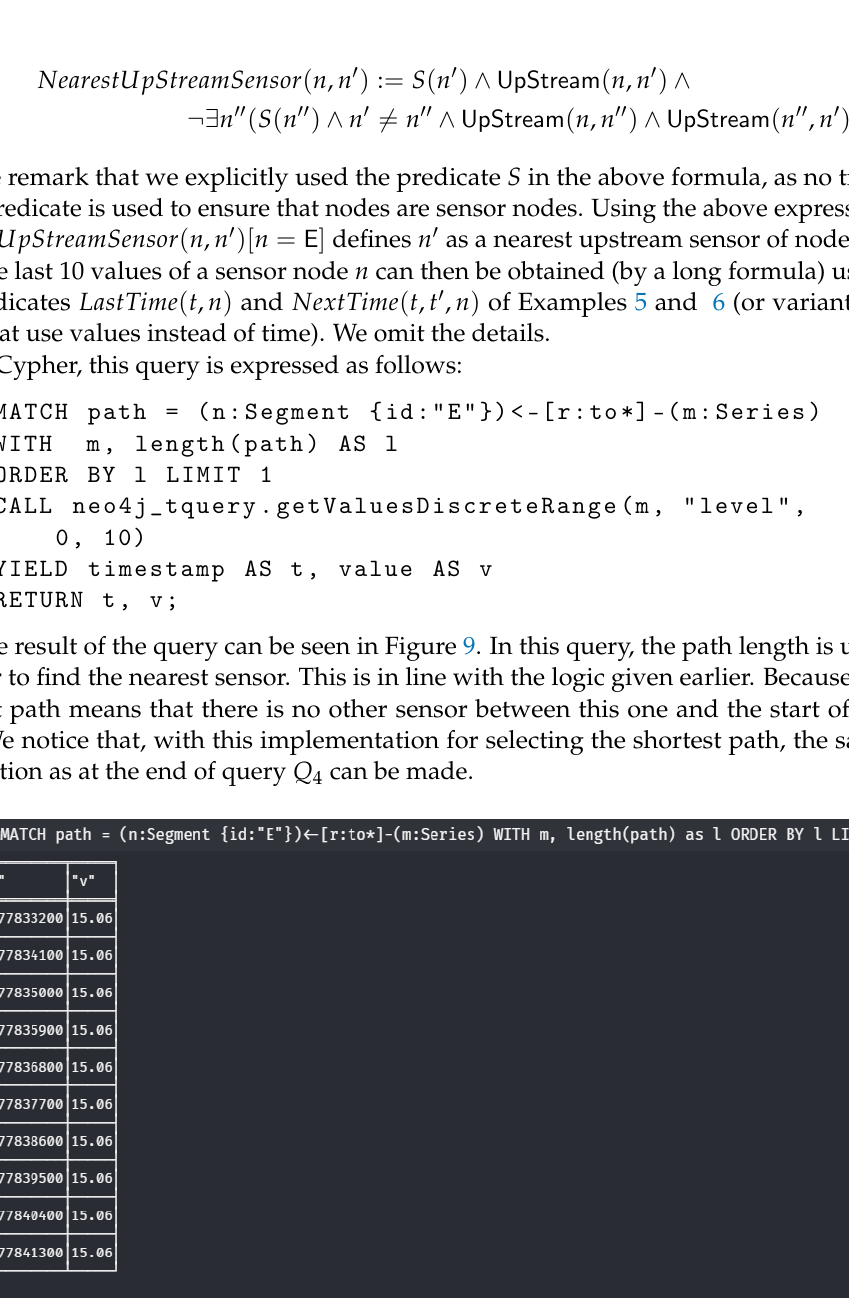
Figure 9. Visualization of the output of query Q 5 run on the sensor network of Figure 4. The result is taken from the web interface of